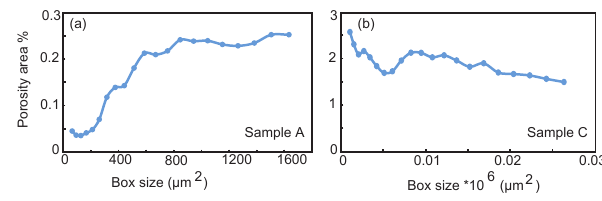
Figure 6. Results of box counting method for BIB-SEM samples A and C. (a) Representative element area (REA) for sample A is at least 900µm 2 . (b) REA for sample C is at least 25000µm 2